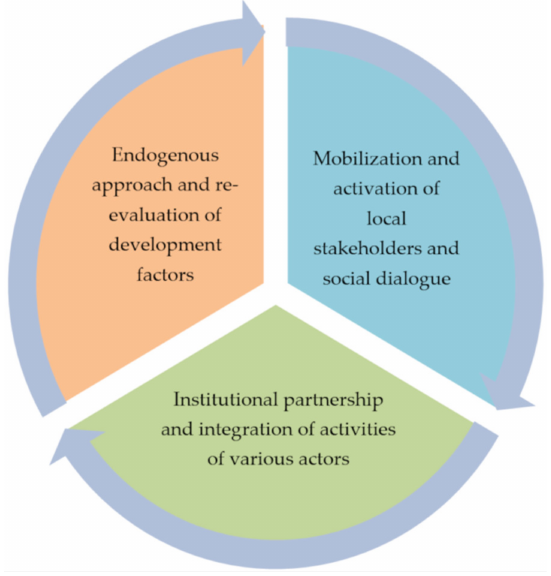
Figure 1. Components of place-based policy approach in the Just Transition process. Source: own